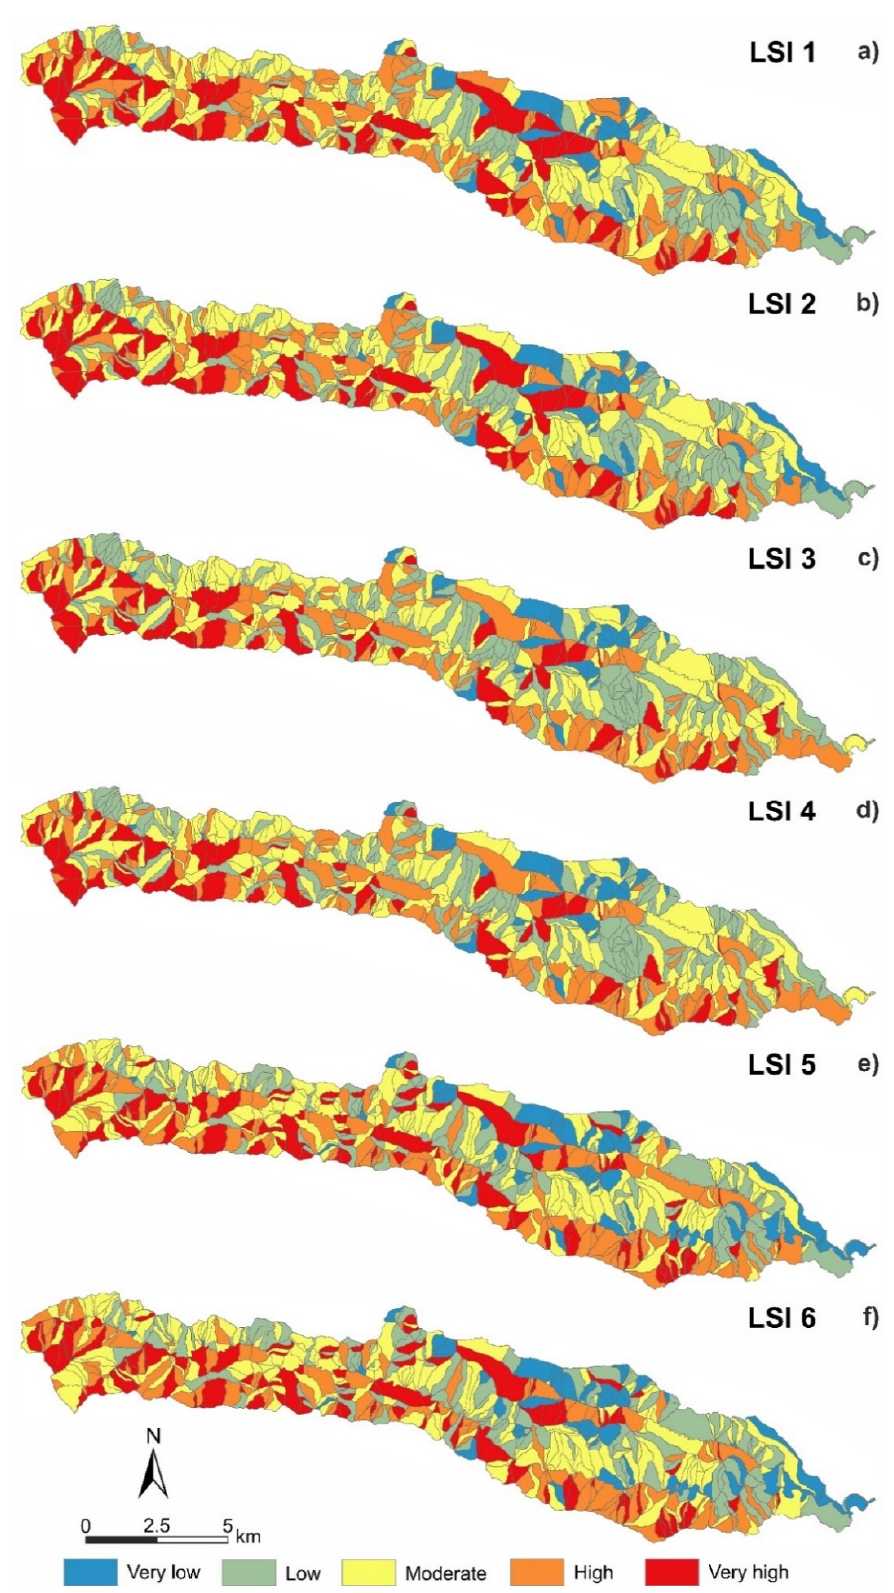
Figure 9. Landslide susceptibility maps created with the LSI method: ( a ) LSI_1 model; ( b ) LSI_2 model; ( c ) LSI_3 model; ( d ) LSI_4 model; ( e ) LSI_5 model; ( f ) LSI_6